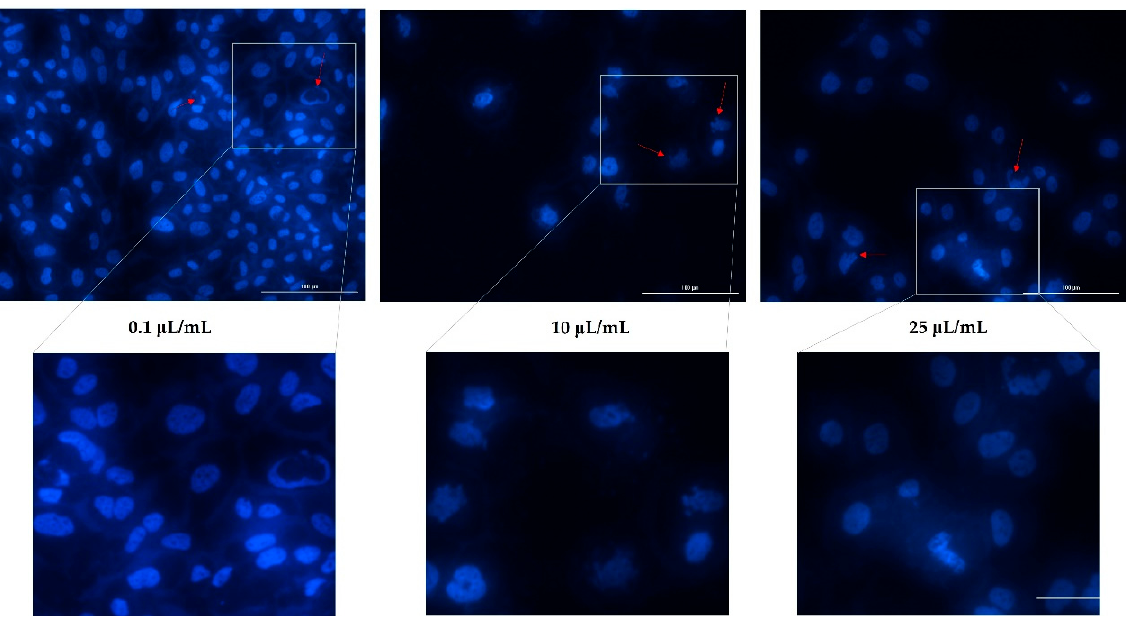
Figure 6. Hepatocytes—HepaRG nuclei stained with Hoechst 33342 dye after 24 h treatment with nicotine (0.1, 10, and 25 μ L/mL). Staurosporine (5 μ M) was used as the positive control for apoptotic changes at the nuclear level. The red arrows indicate signs of apoptosis. The scale bars represent 100 μ m.